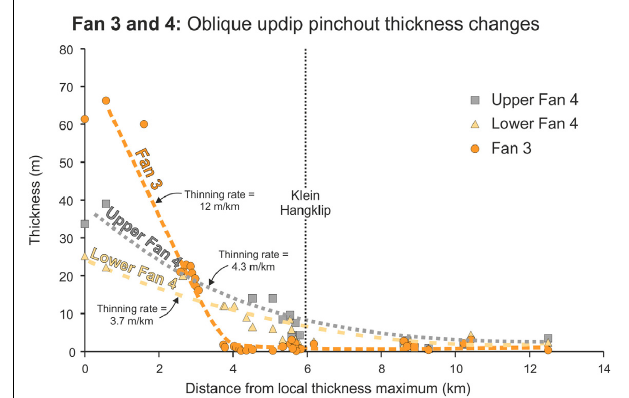
FIGURE 10 | Thickness changes of Fan 3, lower Fan 4 and upper Fan 4 at the oblique up-dip pinchout derived from the correlative stratigraphic interval, showing that the decrease in Fan 3 thickness is much more abrupt compared to lower and upper Fan 4. Note that the trendlines are only indicative of the overall trend and not mathematically